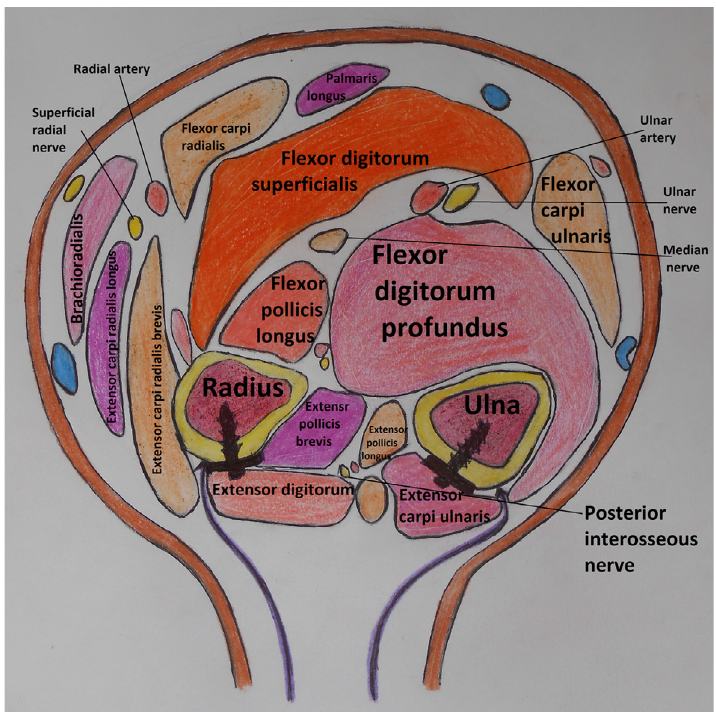
Figure 2. A cross-section in the middle of the forearm demonstrating the exposure of both the radius and the ulna through the single incision and showing the actual exposure of the ulna between the extensor carpi ulnaris and the flexor digitorum profundus muscles. It also demonstrates the relation of the exposure to the neurovascular structures and the position of the plates on the bones.